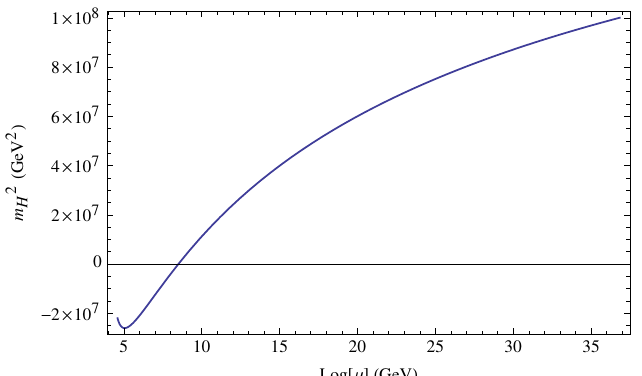
Figure 10. Plot showing the mass-squared going tachyonic for the SU(5) model with (cid:21) = 0 : 2, g = 0 : 45, A = p 8 m H and m H ( m GUT ) = 10